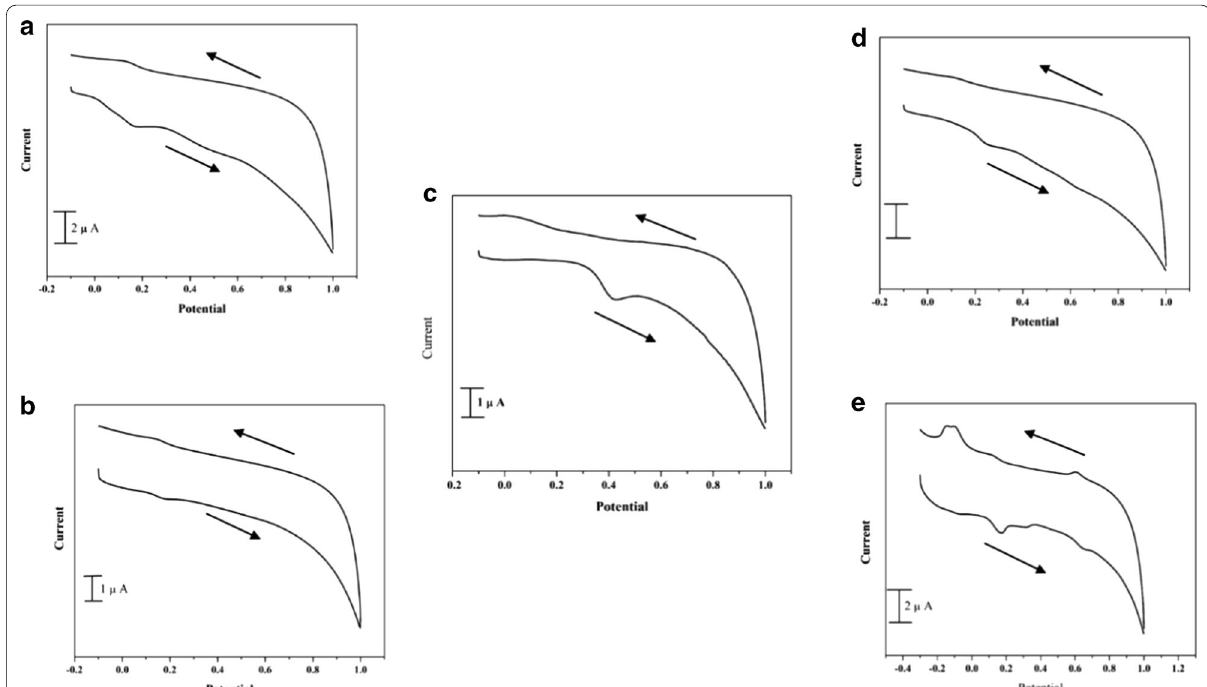
Fig. 1 Voltammograms of ( a ) Madhuca cold ( b ) Madhuca hot ( c ) Neem hot ( d ) simarouba cold and ( e ) simarouba hot acetone extracts